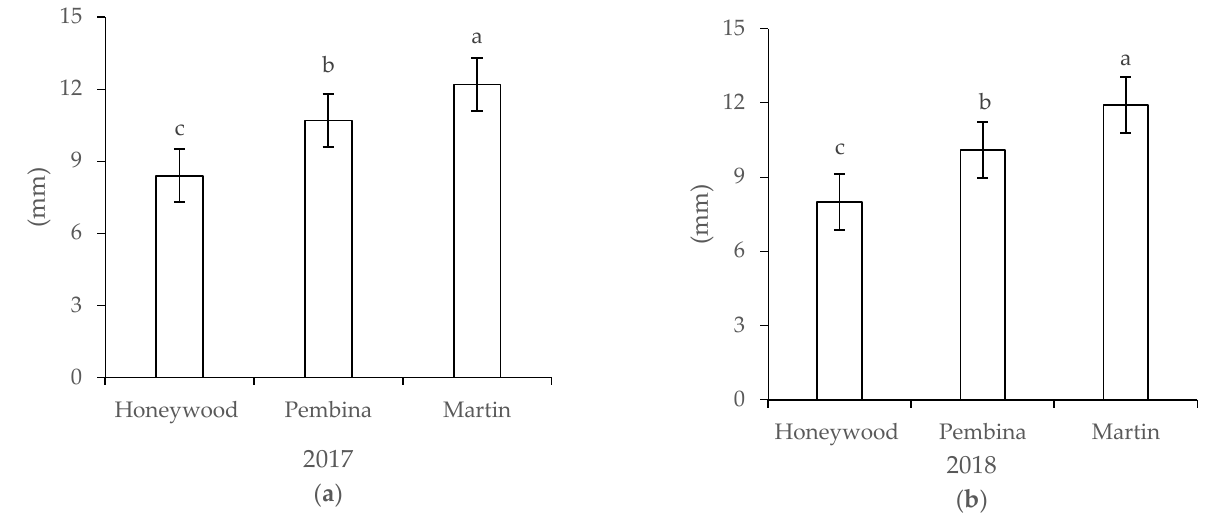
Figure 4. Fruit diameter of the studied cultivars in ( a ) 2017 and ( b ) 2018. Values with different letters are significantly different within a year.